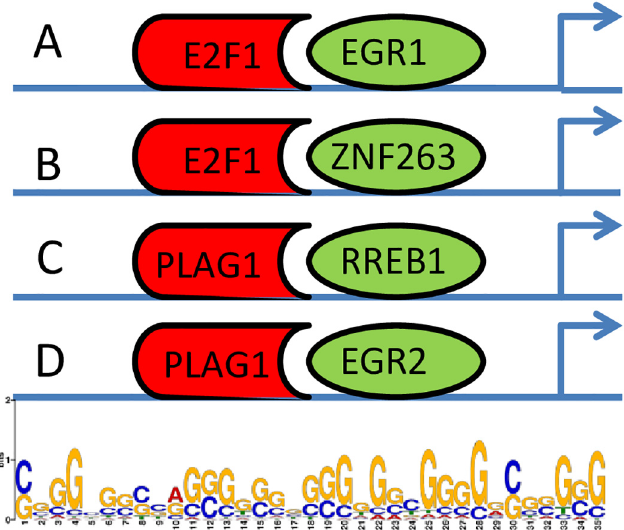
Fig 6. Several TFs may cooperatively regulate the expression of cyclic genes during mouse somitogenesis. A GC rich regulatory motif denoted as A1 in the text was found to be overrepresented in the promoter of nearly ¾ of reported cyclic genes during chicken somitogenesis. The average position of the motif is around 300 bps upstream of the transcription start site for mouse genes. When tested for enrichment in the database of experimentally validated TFBSs, it appears this regulatory motif may contain the binding sites of several couple of TFs acting cooperatively to regulate the expression of corresponding genes. The first and second possibilities (panels A and B) is the TF E2F1 binding upstream of EGR1 and ZNF263 respectively and the others possibilities (panels C and D) involve the TF PLAG1 binding upstream of RREB1 and